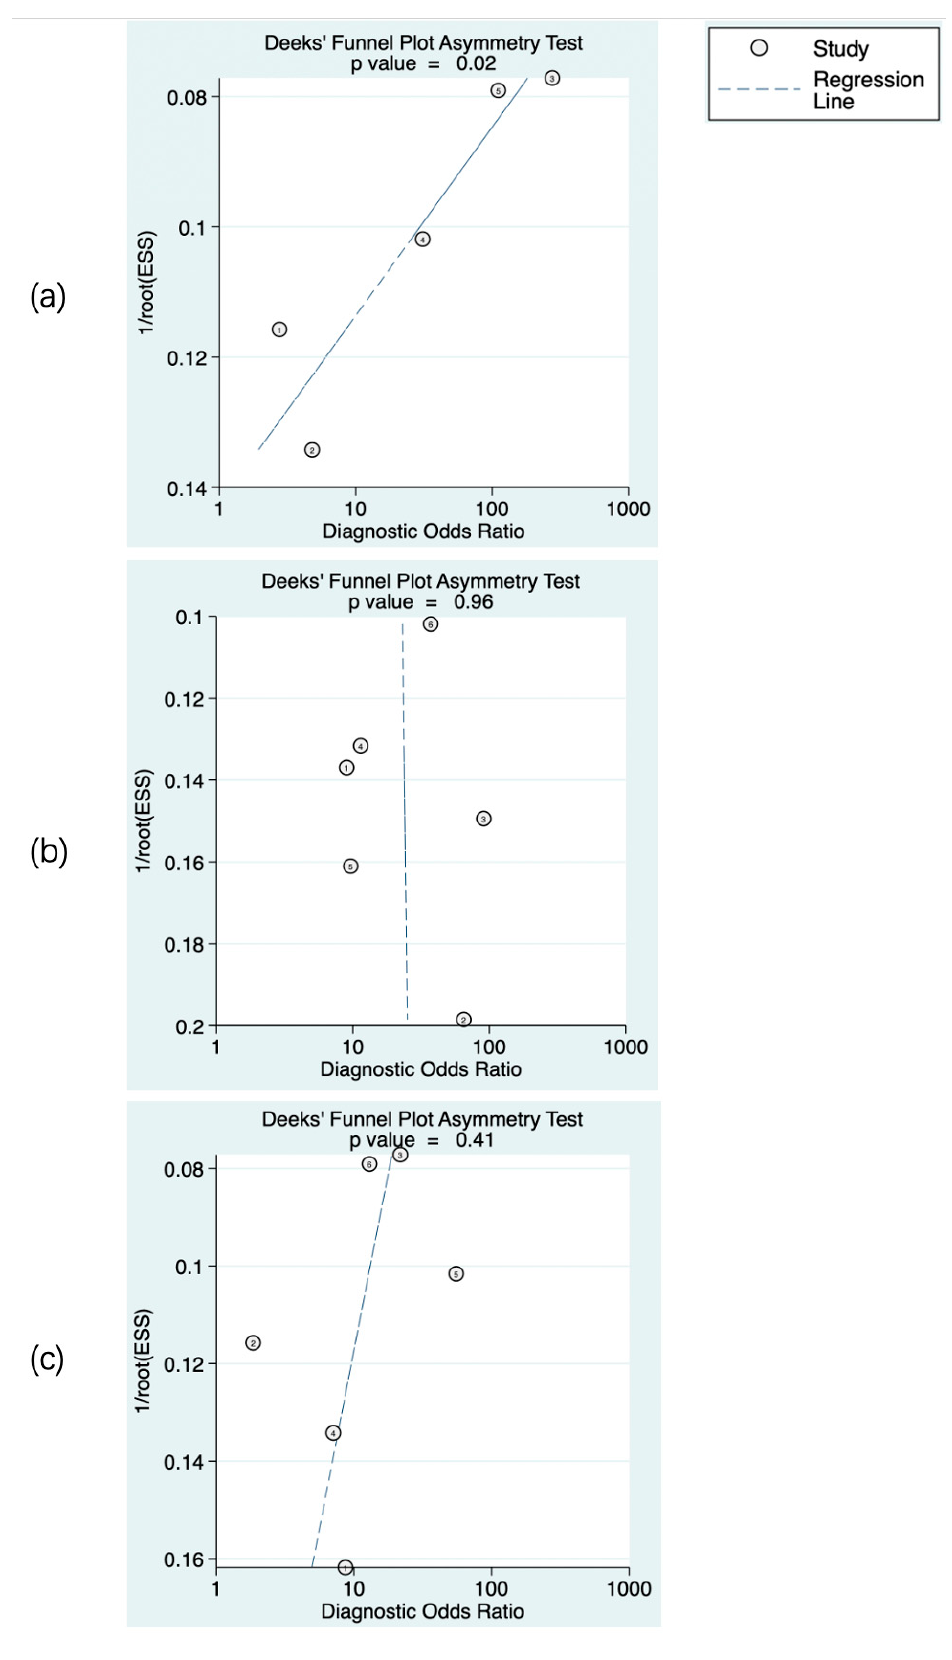
Figure 6. Publication bias of the studies included. rCBF ( a ), rPS ( b ), and rCBV ( c ). The numbers in the figures denote the data from different studies.